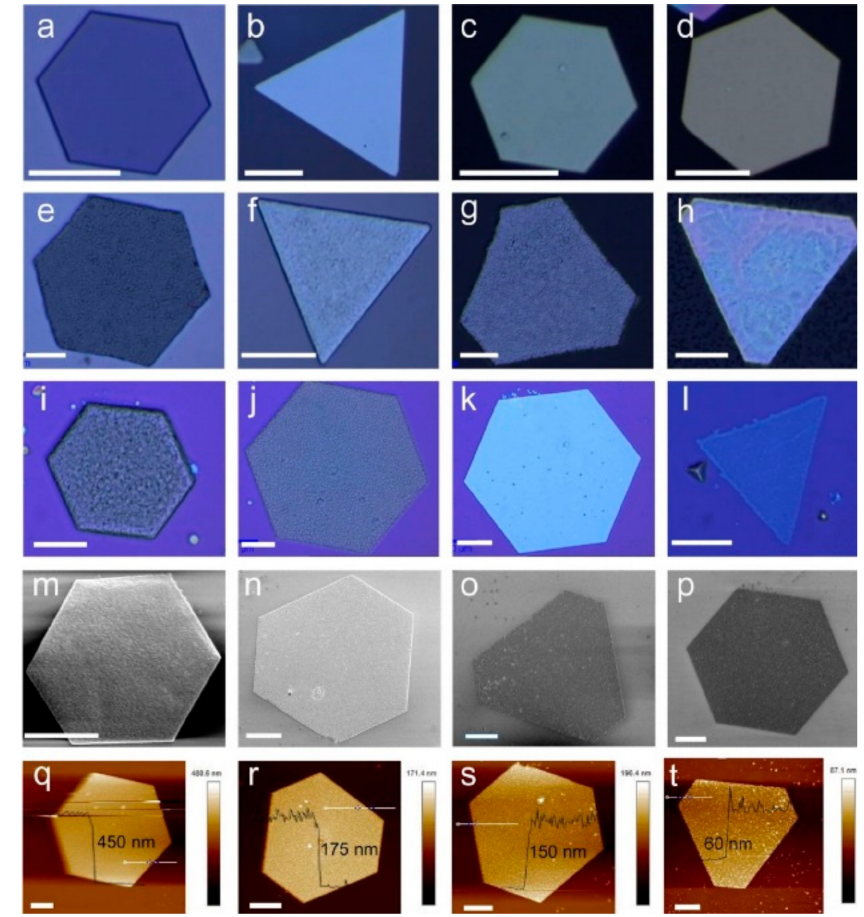
Figure 1. ( a – d ) Optical microscopy images of the hexagonal and triangular 2D PbI 2 platelets on Si, mica, glass and PDMS substrates, respectively; ( e – h ) Optical microscopy images of the hexagonal and triangular 2D CH 3 NH 3 PbI 3 perovskite on Si, mica, glass and PDMS substrates, respectively; ( i – l ) and ( m – p ) Optical microscopy and SEM images of 2D CH 3 NH 3 PbI 3 perovskite with different thicknesses from hundreds of nanometers to single unit cell thick (2 nm) on SiO 2 /Si substrate; ( q – t ) AFM topography images of 2D CH 3 NH 3 PbI 3 perovskite platelets with different thicknesses from 450 nm to 60 nm, respectively. All the scale bars are 10 µ